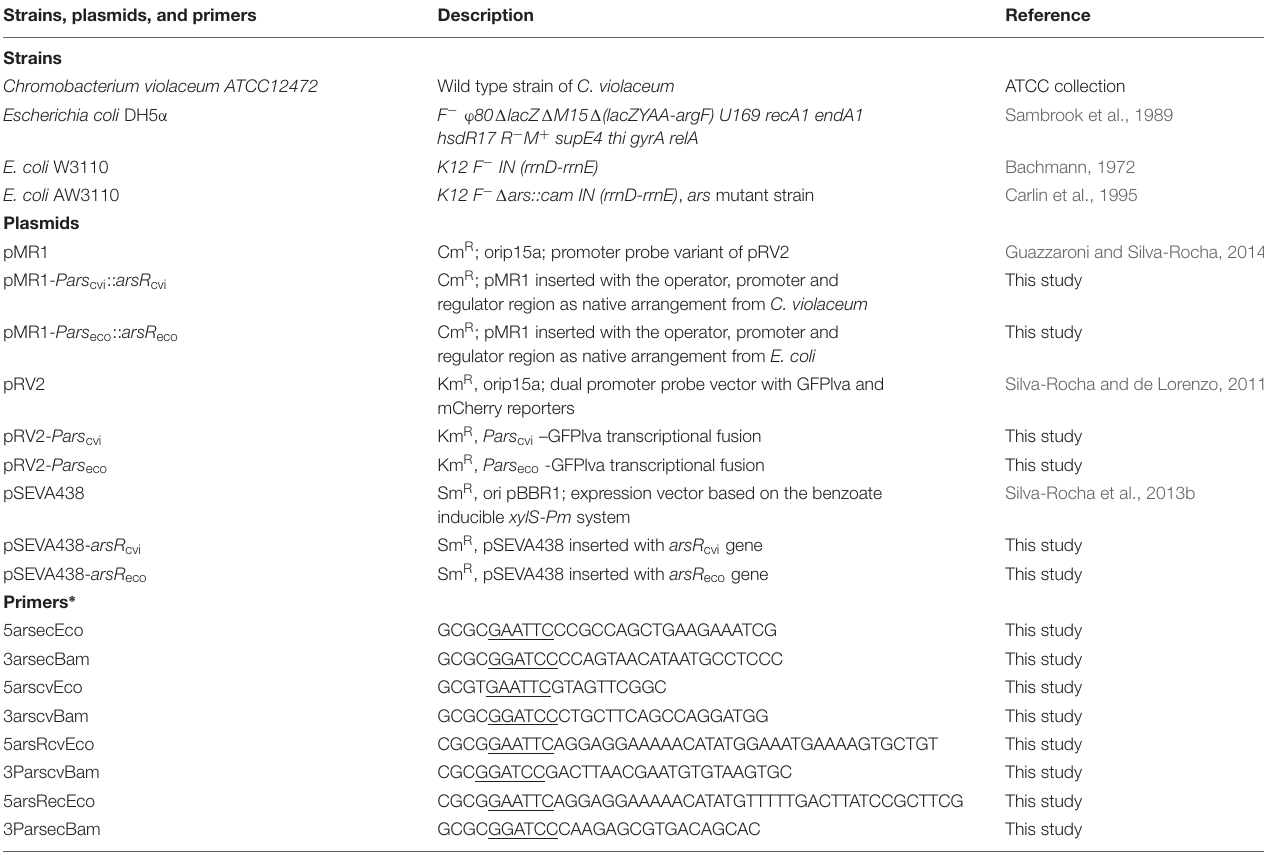
TABLE 1 | Strains, plasmids, and primers used in this